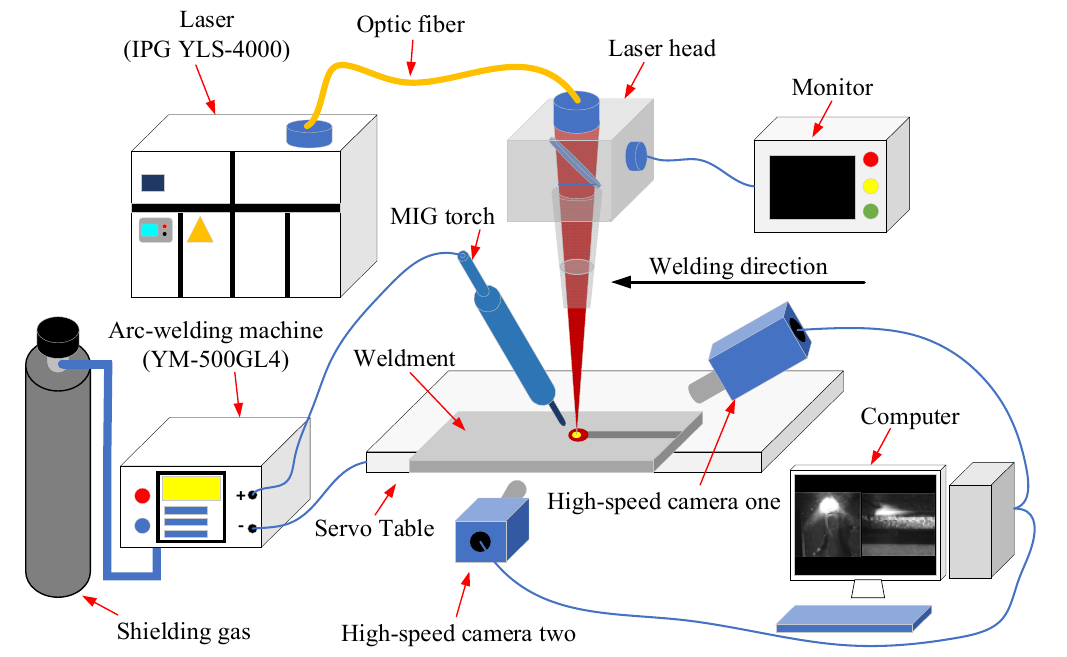
Figure 1. Device system diagram of laser-MIG hybrid welding.